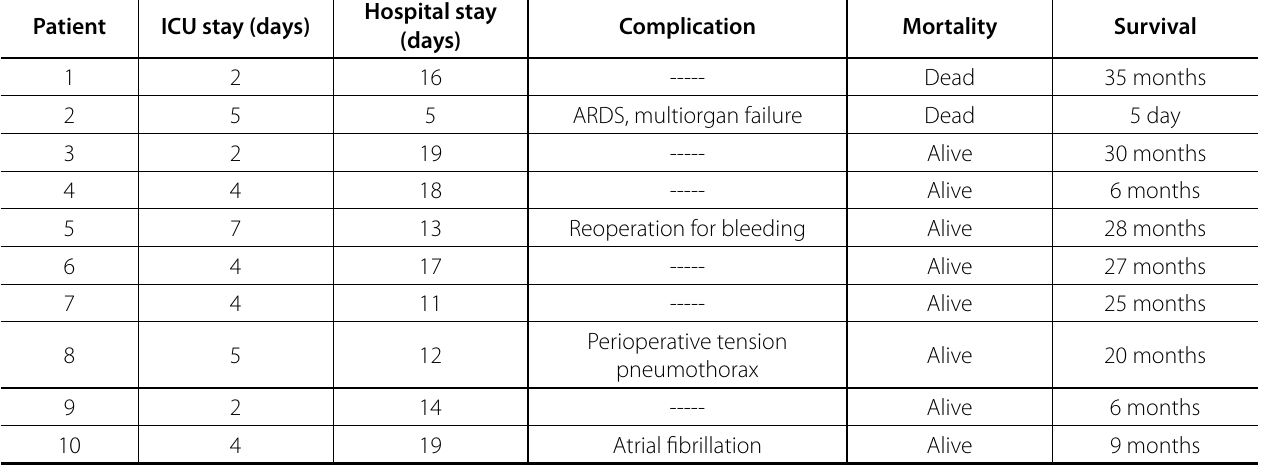
Table 4. Postoperative